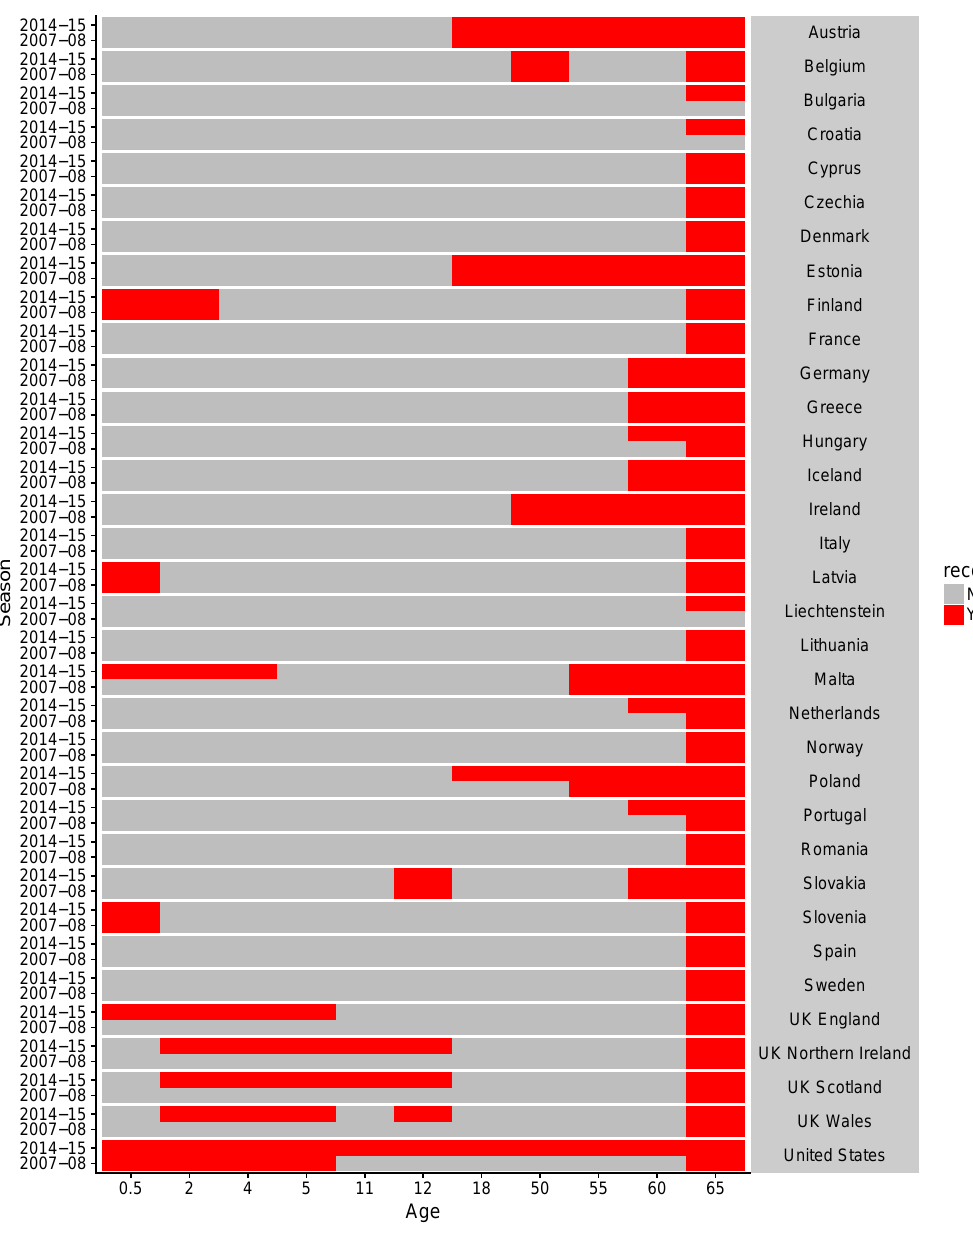
Figure A4. Seasonal influenza vaccination recommendations by age group in Europe [46] and the United States [47] during the 2007–2008 season and the 2014–2015